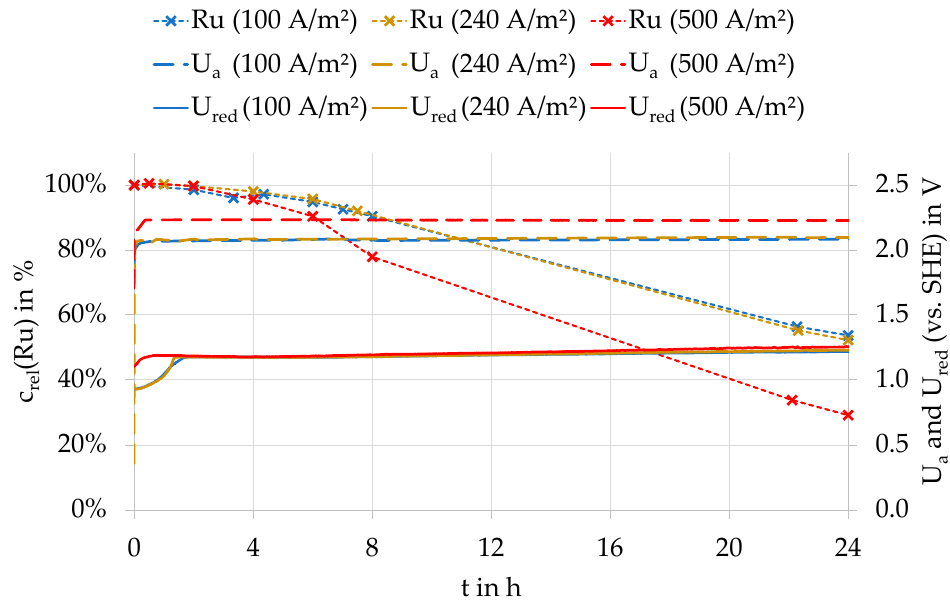
Figure 3. Relative ruthenium concentration (c rel (Ru)), anodic potential (U a ), and redox potential (U red ) at different current densities during an electrolysis with a PbSnCa anode at 40 °C.